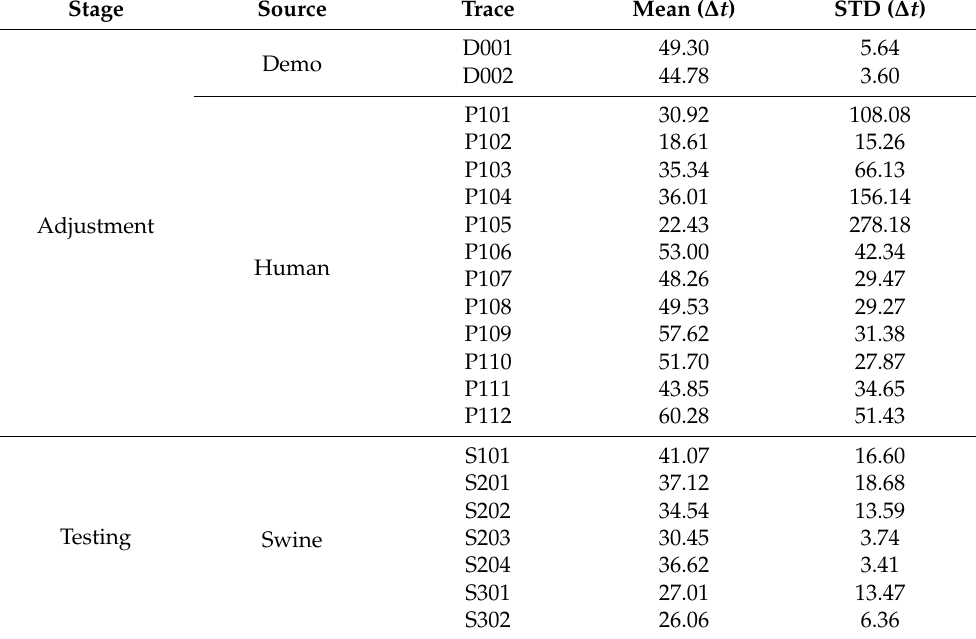
Table 2. Comparison between the time when high TTL states are pulled by the algorithm ( t a ) and